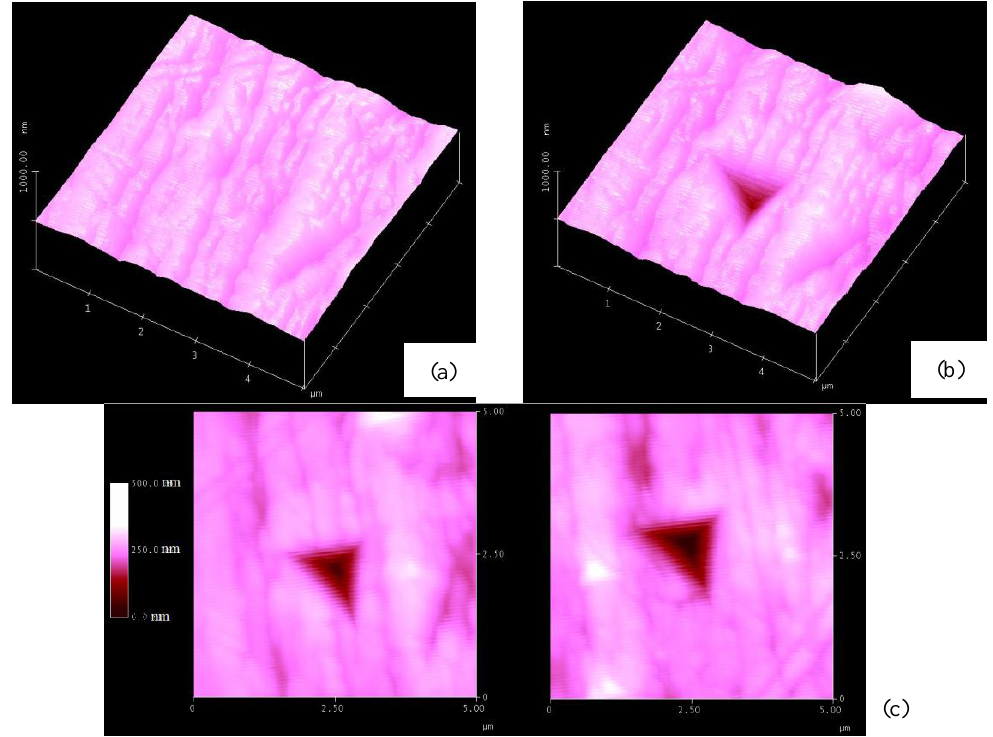
Figure 7. Atomic force microscopy (AFM) images of ( a ) 3D aluminum 1100 indentation surface, ( b ) 3D view of the nanoindentation mark, and ( c ) top view of the indentation mark samples from the nanoindentation experiment on aluminum 1100.